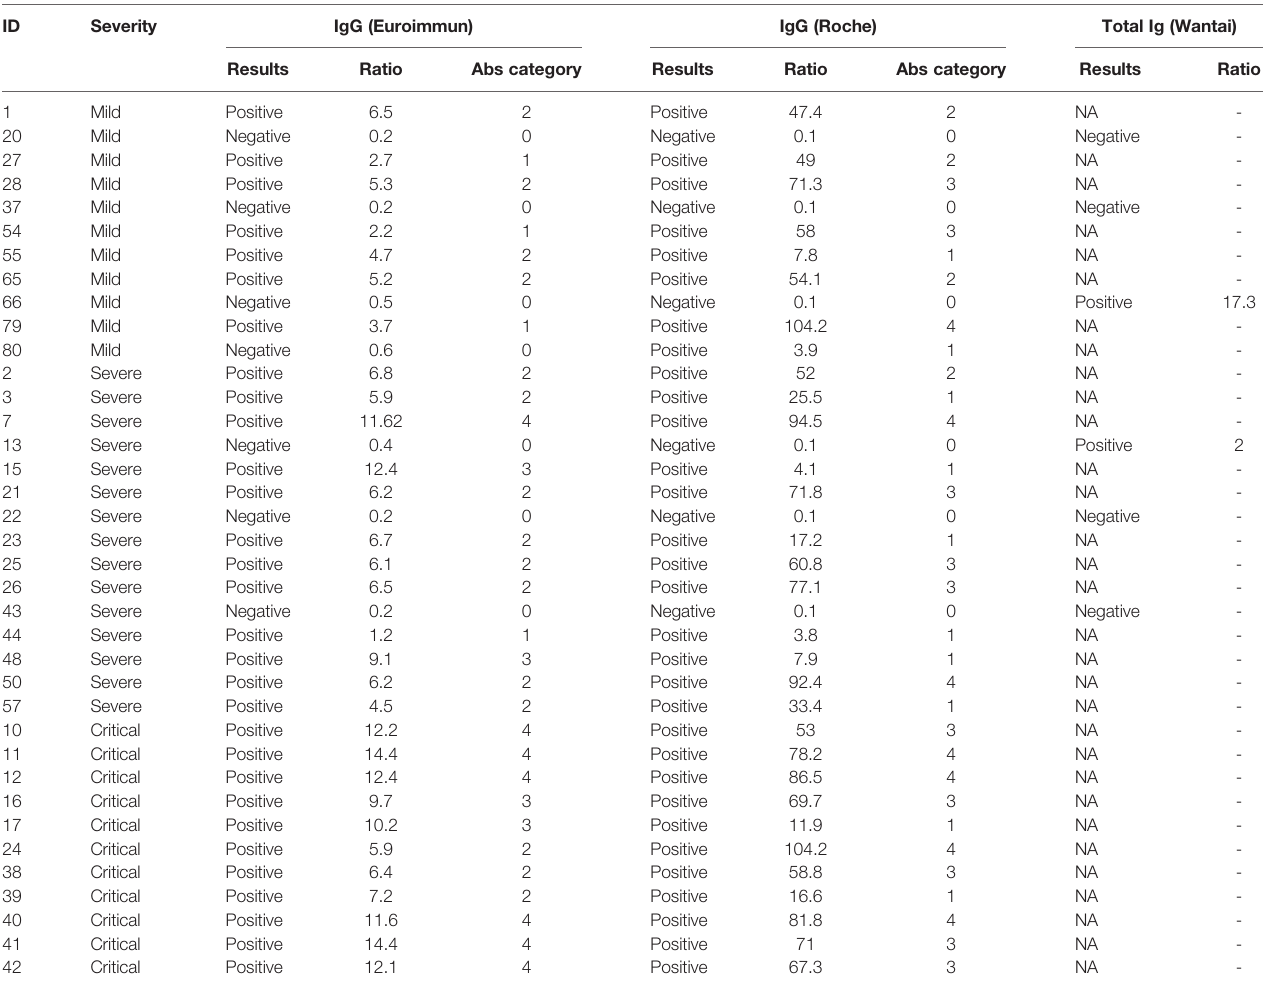
TABLE 2 | SARS-CoV-2-speci fi c antibodies evaluated from patients with mild, severe and critical